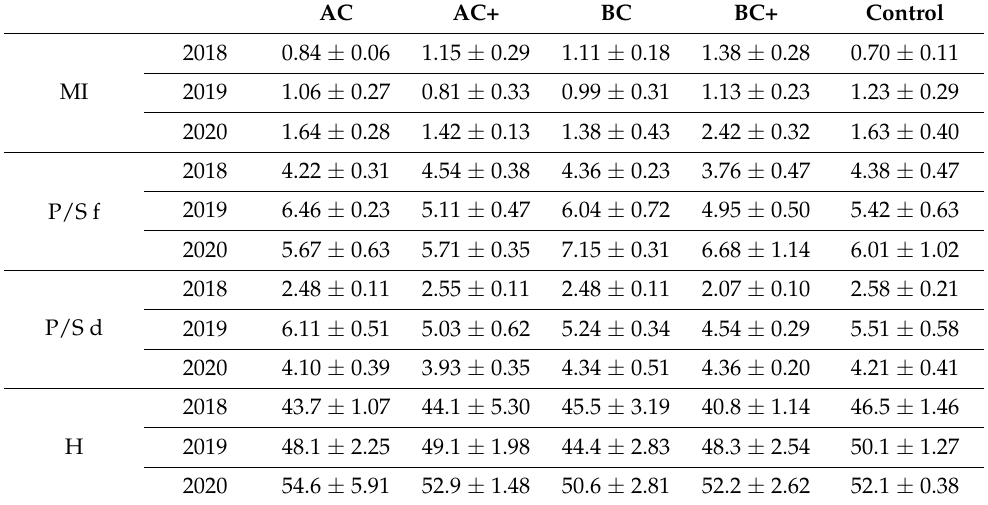
Table 4. Summary of yield quality during the 3 years of the experiment under different treatments: AC (alperujo compost), AC+ (high dose of alperujo compost), BC (biosolid compost) and BC+ (high dose of biosolid compost). Data are mean values ± standard error of the mean